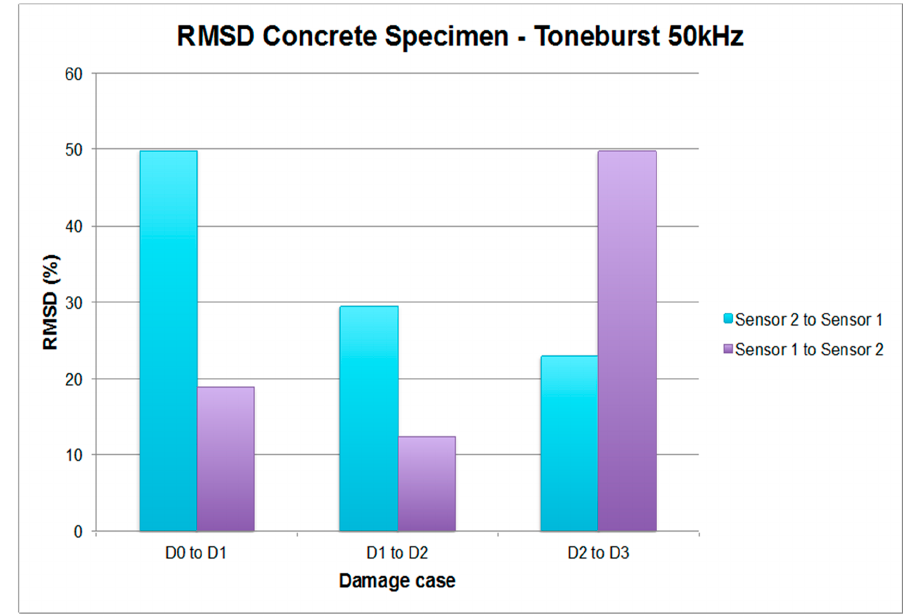
Figure 16. RMSD values for the concrete specimen.